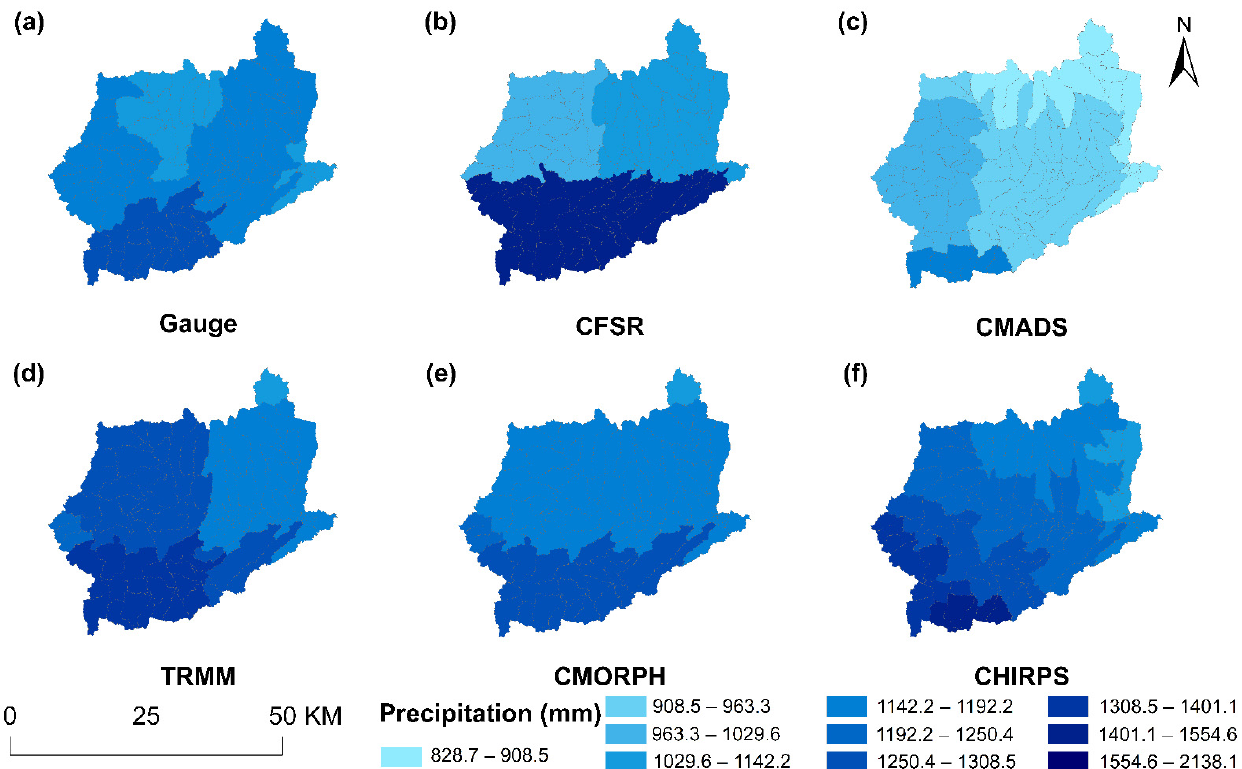
Figure 10. Spatial distributions of annual mean precipitation using different precipitation data during 2009–2014, including ( a ) Gauge, ( b ) CFSR, ( c ) CMADS, ( d ) TRMM, ( e ) CMORPH, and ( f ) CHIRPS.